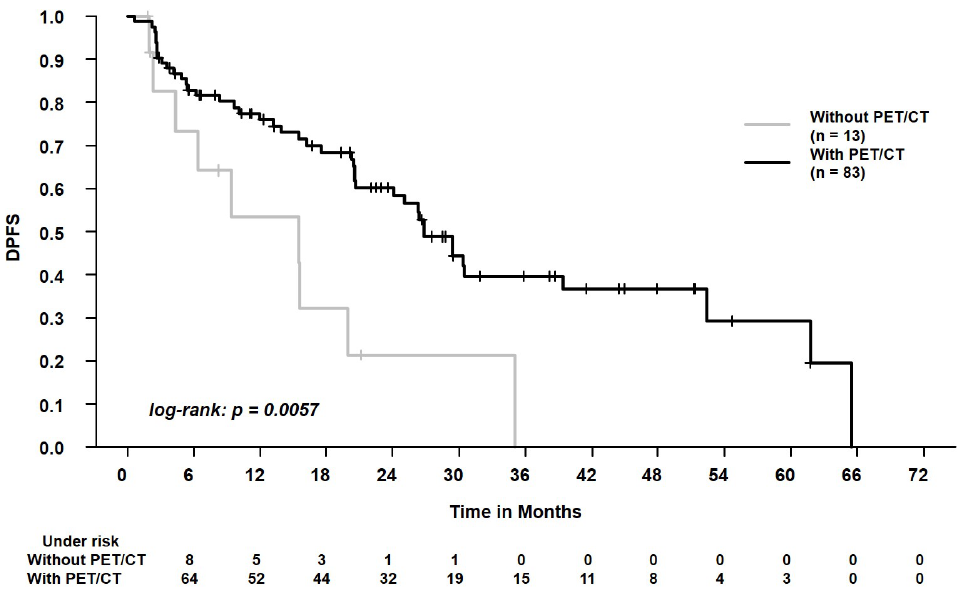
Figure 3. Distant progression-free survival (DPFS) in patients who were staged with positron emission tomography/computed tomography (with PET) vs. patients who were staged with conventional chest CT scan (without PET). The 2-year DPFS was 60.3% vs. 21.4%.